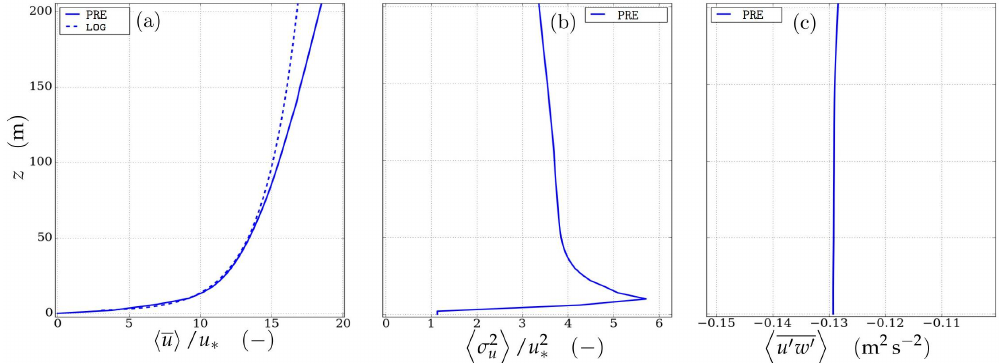
Figure 3. Double-averaged vertical profiles characterizing the precursor flow solution: ( a ) nondimensional u -component profile (solid blue line) juxtaposed with a reference logarithmic profile (dashed blue line); ( b ) nondimensional variance profile of u ; and ( c ) vertical momentum flux